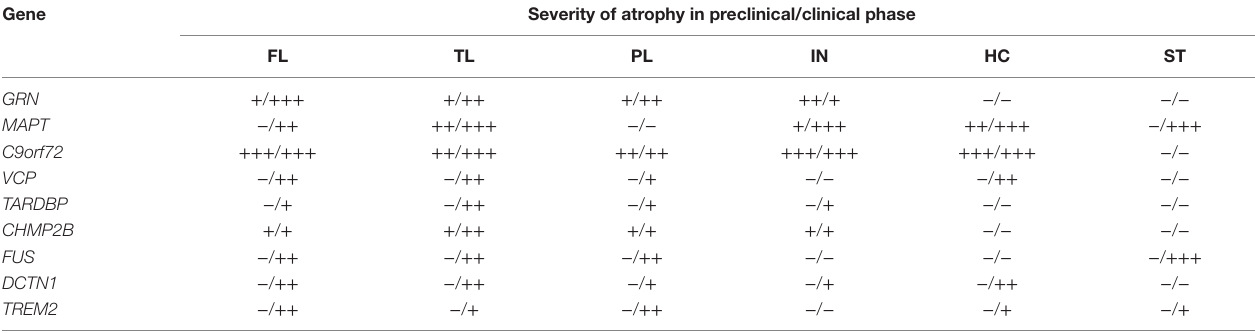
TABLe 2 | Preclinical and clinical neuroanatomical correlates in monogenic FTLD.